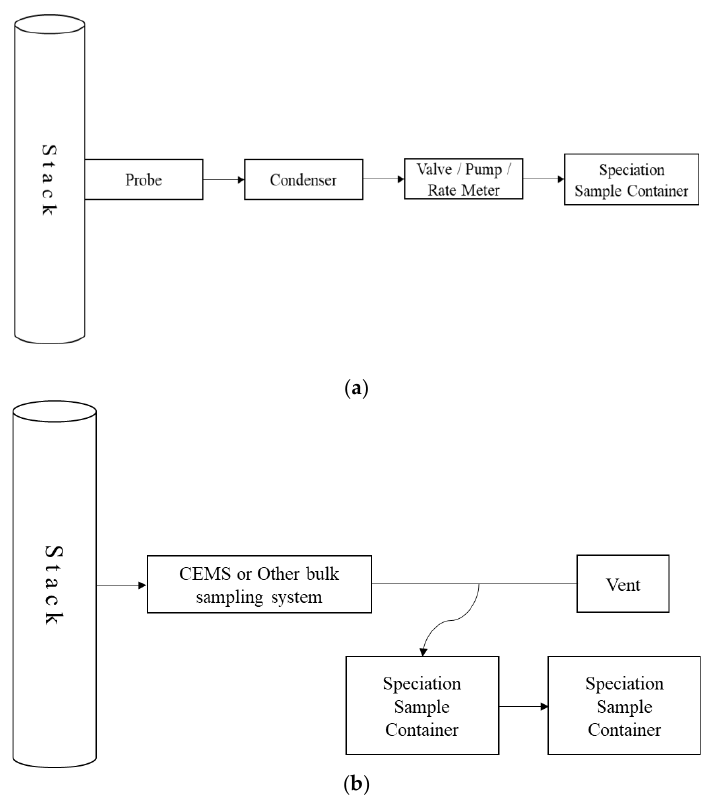
Figure 3. Sampling method of waste flue gas in ASTM D7459. ( a ) Sampling equipment applied to incineration facilities where CEMS is not installed; ( b ) sampling equipment applied to incineration facilities where CEMS is installed.